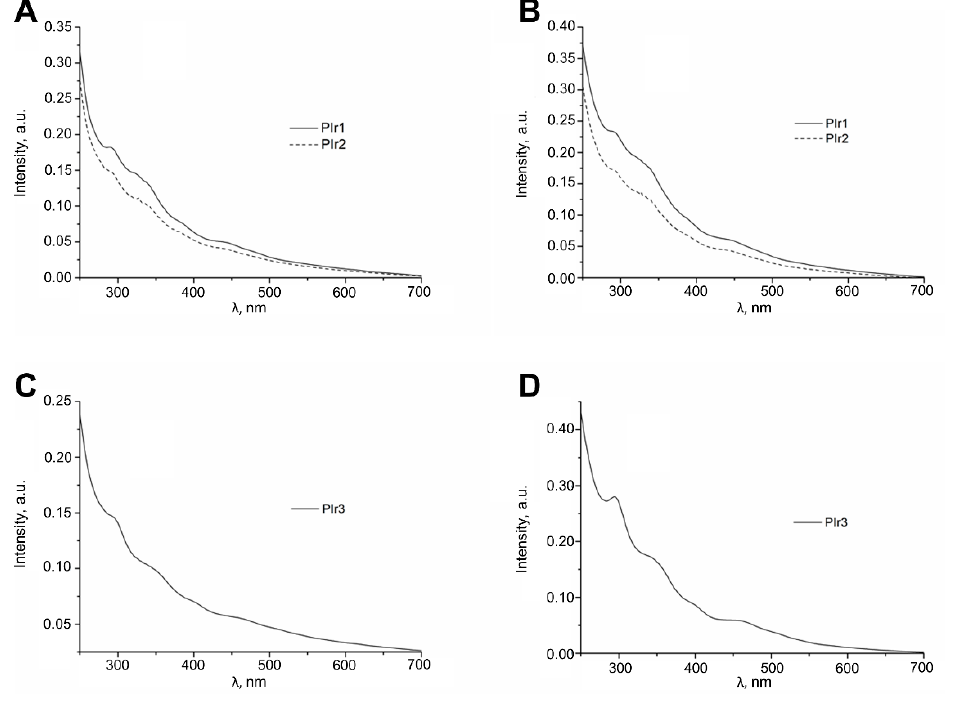
Figure 2. Absorption spectra of PIr1–PIr3 in CH 2 C l2 solution ( A , C ) and in H 2 O solution ( B , D ). The wide emission bands with maxima at 588 nm (PIr1, PIr2) and 605 nm (PIr3) observed in the photoluminescence spectra of the probes in methylene chloride and water (Figure 3, Tables 1 and 2) are associated with 3 MLCT and ligand-centered ( 3 LC) transitions in cyclometalated iridium complexes bonded to the polymeric platform [18–20]. The chromaticity coordinates of the photoluminescence spectra of iridium-containing probes in the CIE (Commission Internationale de l’Eclairage) diagram (Tables 1 and 2) correspond to orange (PIr1, PIr2) and reddish-orange (PIr3) colors. The photophysical characteristics of PIr1 are close to the corresponding parameters of PIr2 (Tables 1 and 2) and, therefore, it can be assumed that additional units with amino acid fragments in the polymer matrix of PIr2 do not noticeably change its photophysical properties in comparison with those of PIr1. A similar feature was found recently for luminescent iridium-containing polynorbornenes with cyclometalated iridium(III) complexes bonded to polymer chains via pyrazolonate anchor ligands